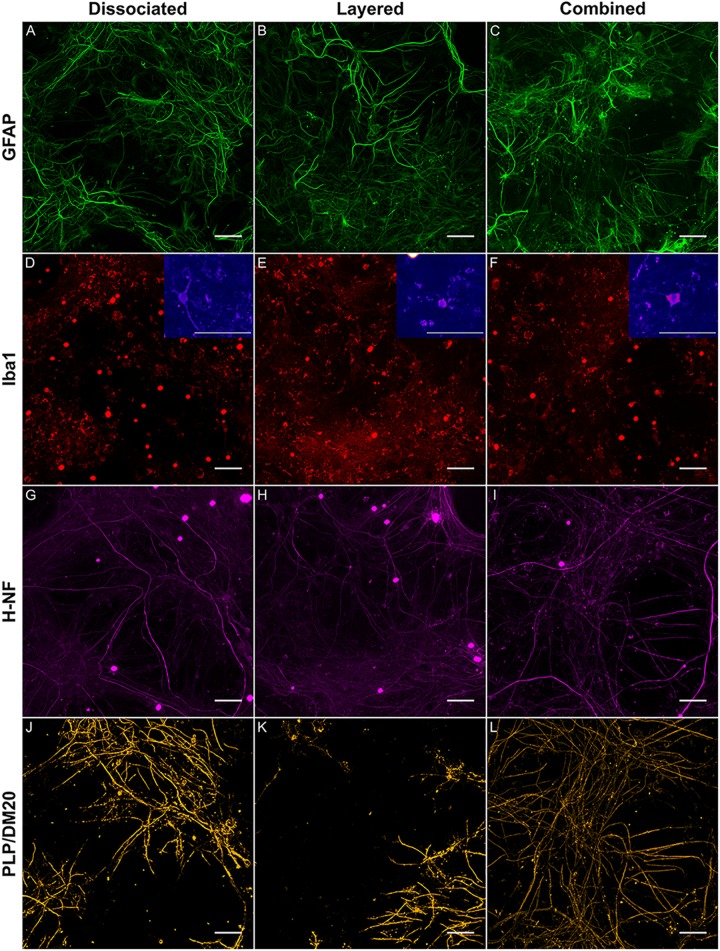
Representative maximum intensity projections comparing the layered and concurrent co-cultures to the DMMC method. GFAP (A–C) staining in astrocytes, Iba1 (D–F) staining in microglia, H-NF (G–H) staining in axons and PLP/DM20 (J–L) staining mature myelin, Insets in D–F show enlargements of the ramified microglia morphologies present in the cultures. Large saturated round structures Iba1 and H-NF (D–I) panels are artefacts and were excluded from analysis.